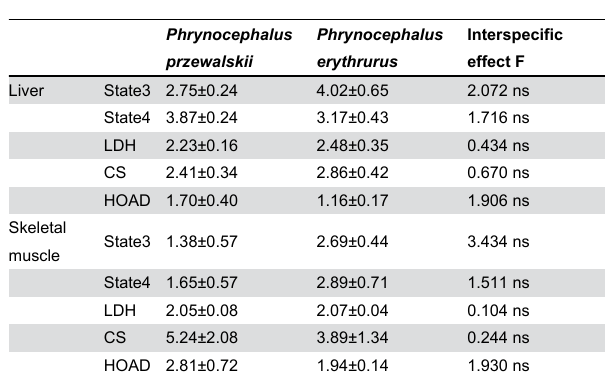
Table 4. Thermal sensitivity (Q ) of mitochondrial oxidation 10 and enzyme activities in different tissues of Phrynocephalus przewalskii and Phrynocephalus erythrurus